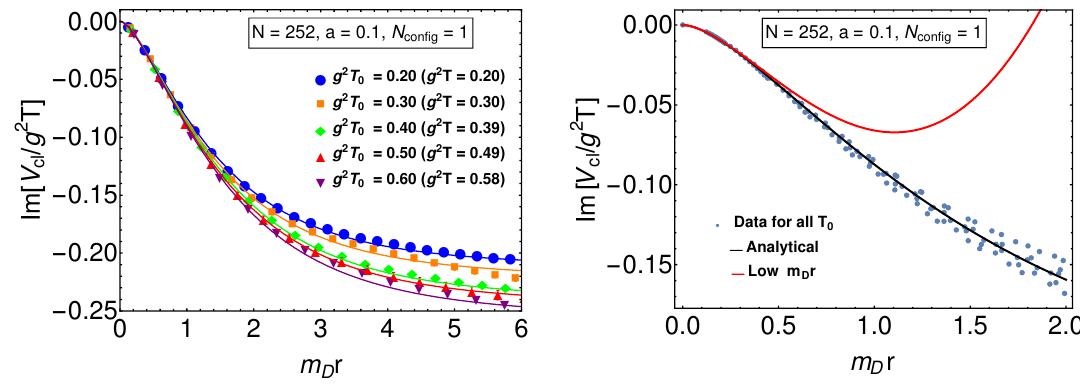
Figure 9 . (Left) The extracted classical potential Im[ V cl ( r )] /g 2 T as a function of m D r for fixed lattice spacing a = 0 . 1 but for different temperatures g 2 T = 0 . 2 , . . . , 0 . 59 , which correspond to the range β = 300 , . . . , 100 . The continuous curves are fits to our data points using the form of the potential in (3.5). (Right) The combined data of the left panel, with additional data sets for g 2 T 0 = 0 . 25 , 0 . 35 , 0 . 45 , 0 . 55 , 0 . 65 , is compared to the analytical form (3.5) with parameter val- ues (3.12) and its low-distance limit (3.13) as black and red curves,